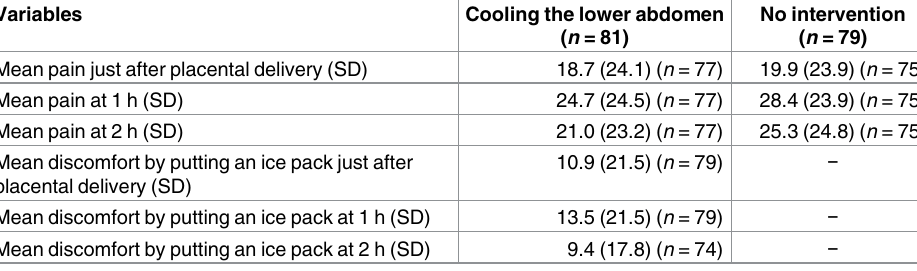
Table 3. Subjective outcomes about pain and